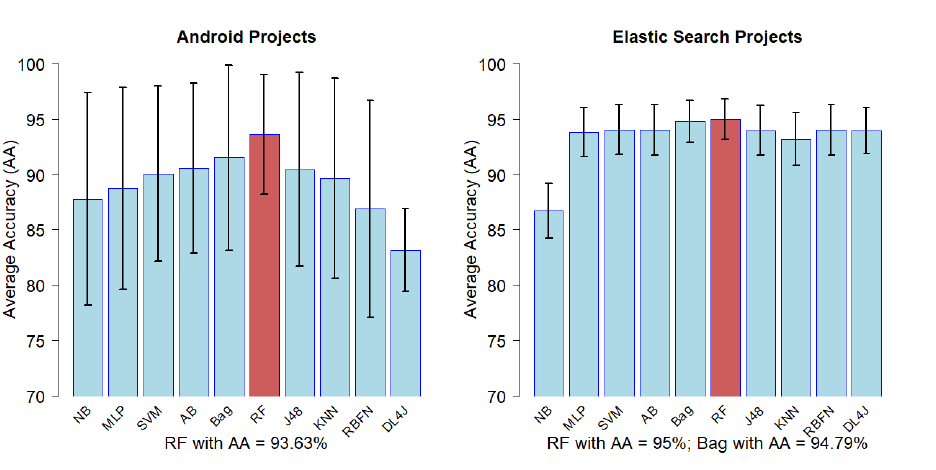
Figure 4. Average Accuracy for the Android and ElasticSearch